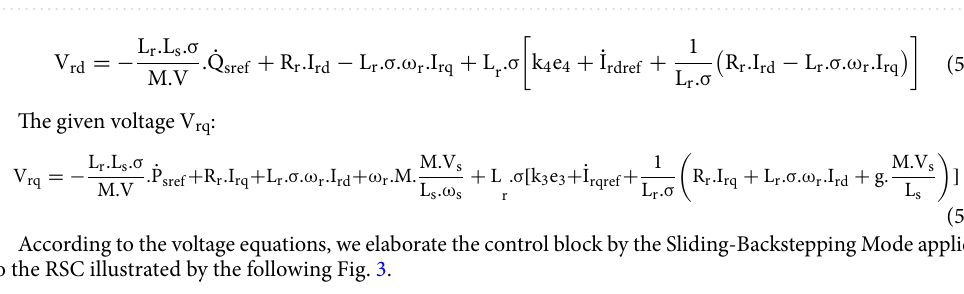
Figure 3. Sliding-Backstepping mode control applied to the